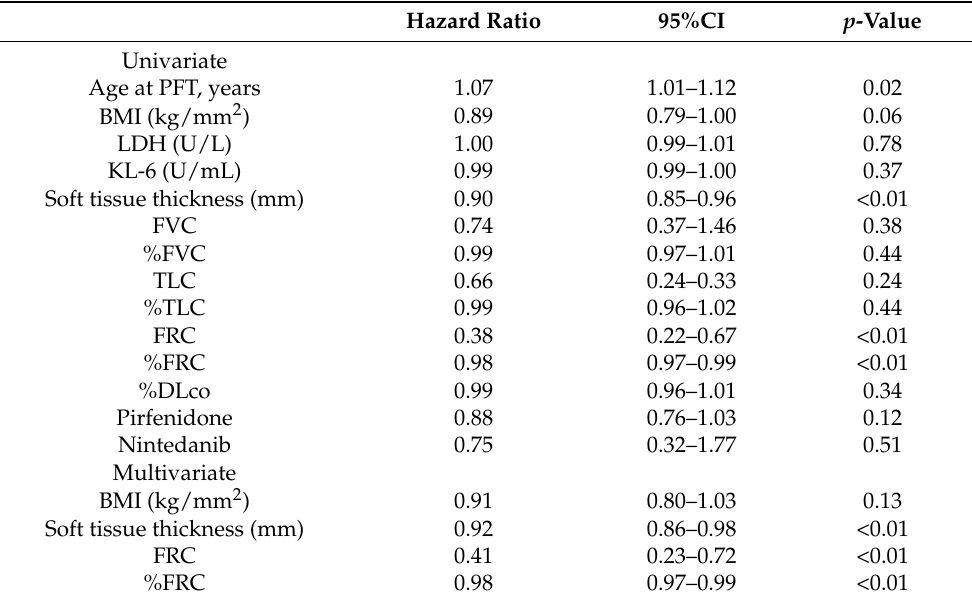
Table 3. Results of hazards analyses for IPF mortality ( n = 39).